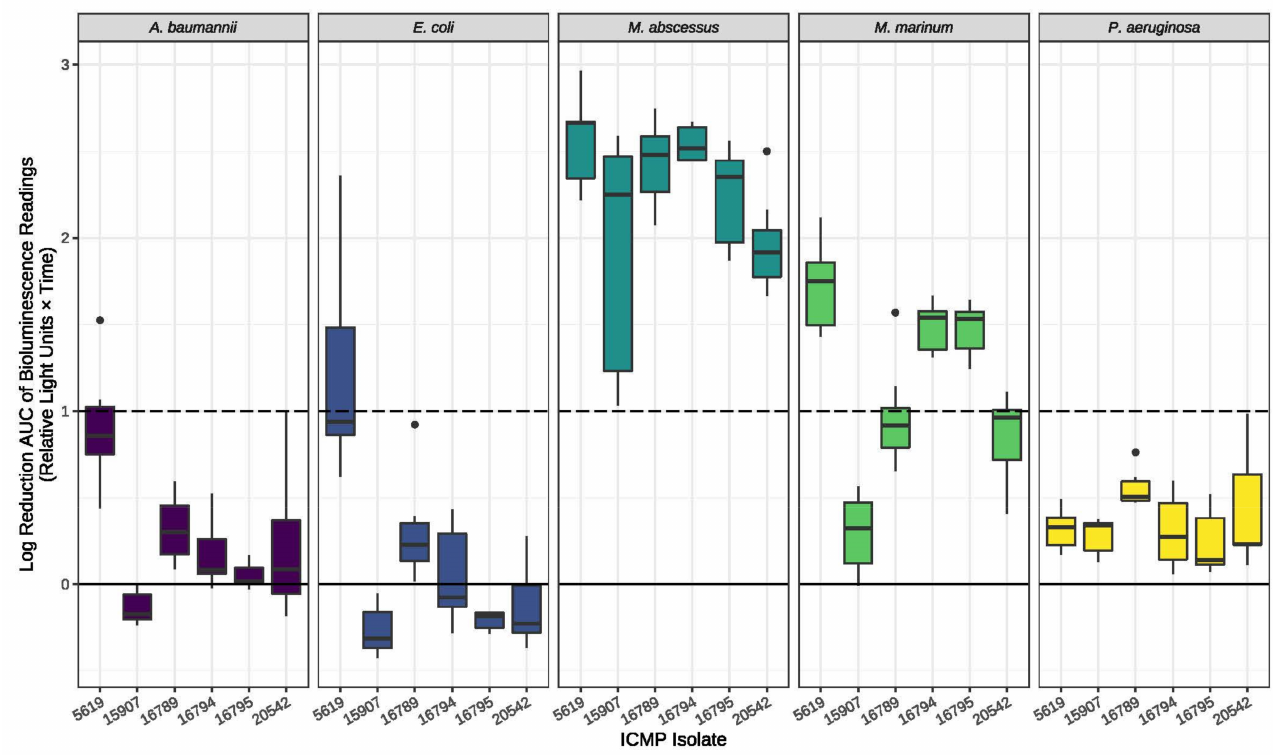
Figure 1. Antibacterial activity of ICMP 5619, 15907, 16789, 16794, 16795, and 20542 against A. baumannii , E. coli , M. abscessus , M. marinum , and P. aeruginosa . Data are presented as box and whisker plots of the activity scores. The solid line shown at 0 is the median control value while the dotted line at 1 is the activity threshold. Scores above 1 correspond to a >90% reduction in bacterial bioluminescence compared to the corresponding no-fungi control. Similarly, an activity score above 2 corresponds to a >99%